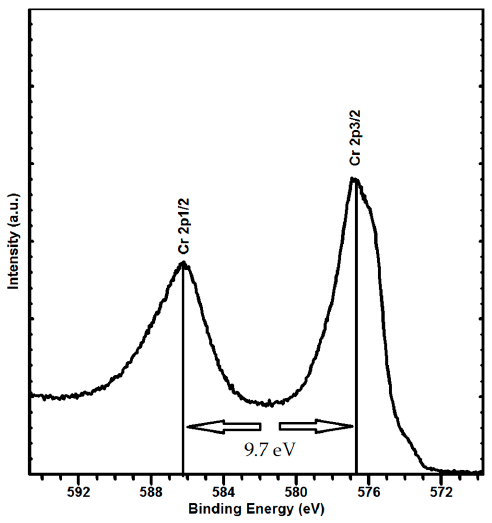
Figure 4. The high-resolution Cr 2p XPS spectrum of coatings deposited at 0.16 Pa pressure.